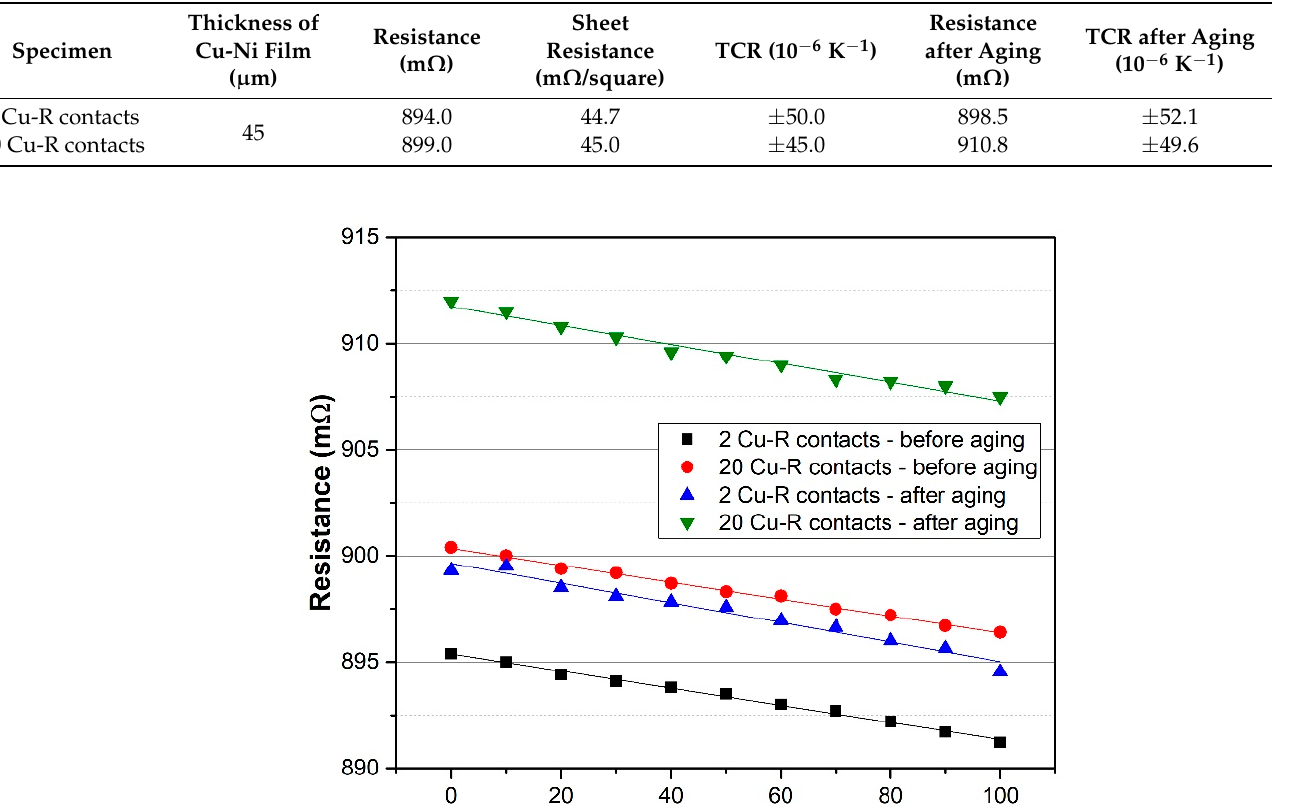
Table 1. Results of copper-nickel IRP specimens measurement (average values from 5 specimens).